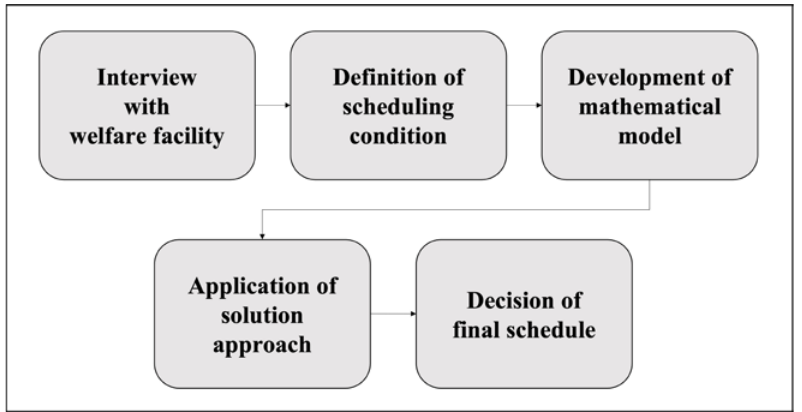
Figure 2. Overall procedure for development of a social workers’ schedule.